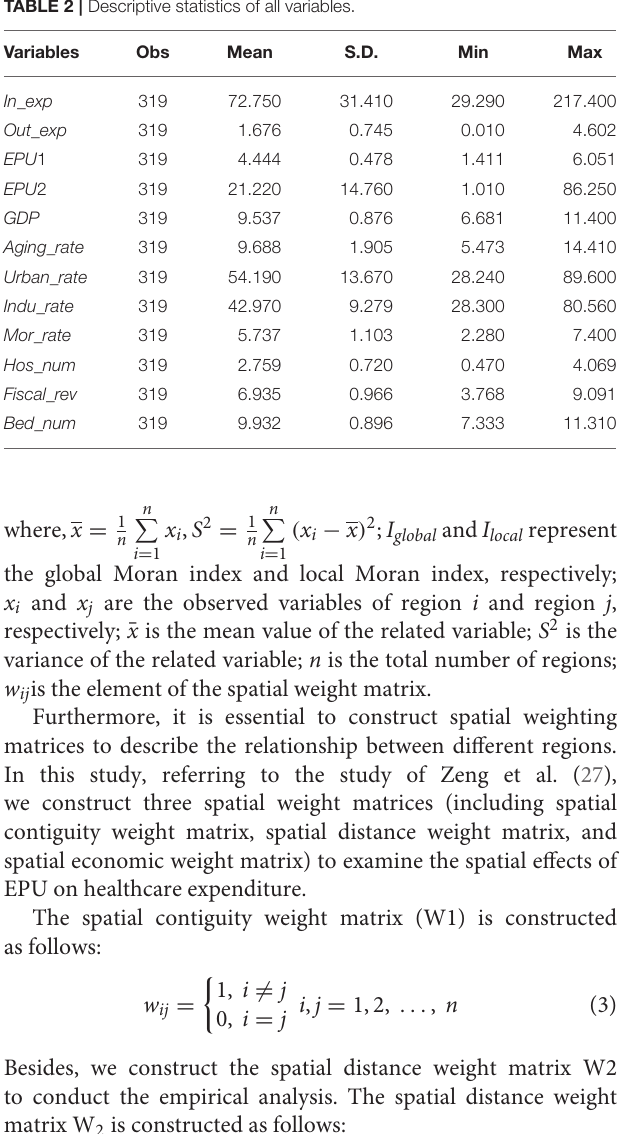
TABLE 1 | Description of the variables. TABLE 2 | Descriptive statistics of all